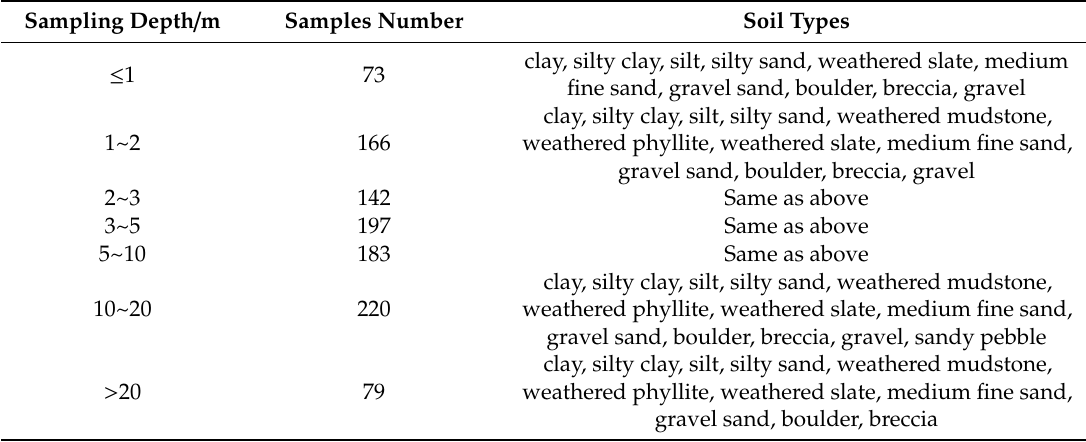
Figure 1. Schematic of the sampling spot along the Qinghai–Tibet Engineering Corridor (QTEC). Table 1. Sampling depth distribution of testing specimens in the